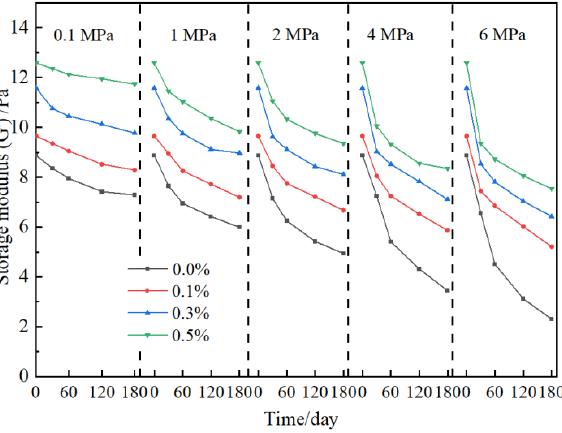
Figure 6. Effect of nano-SiO 2 on gel stability at elevated flue gas